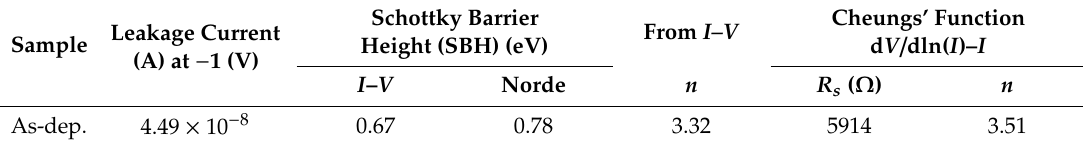
Table 1. The parameters of the I – V characteristics of the Al / SiO 2 / p -MOS Schottky diode at room